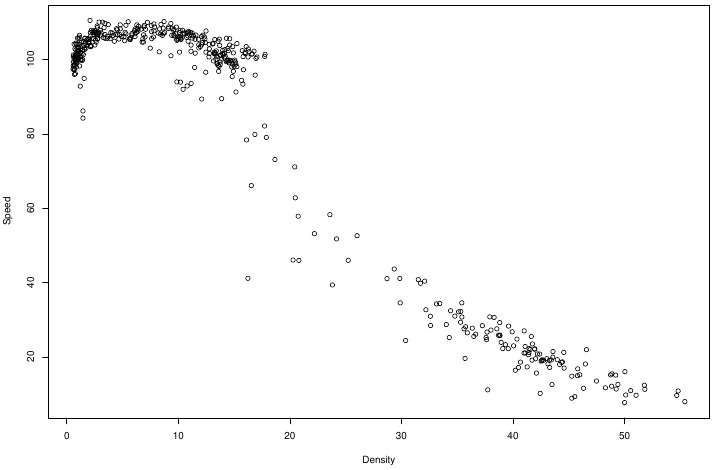
Figure 3. Speed vs. density scatterplot from 1 to 5 June 2021.